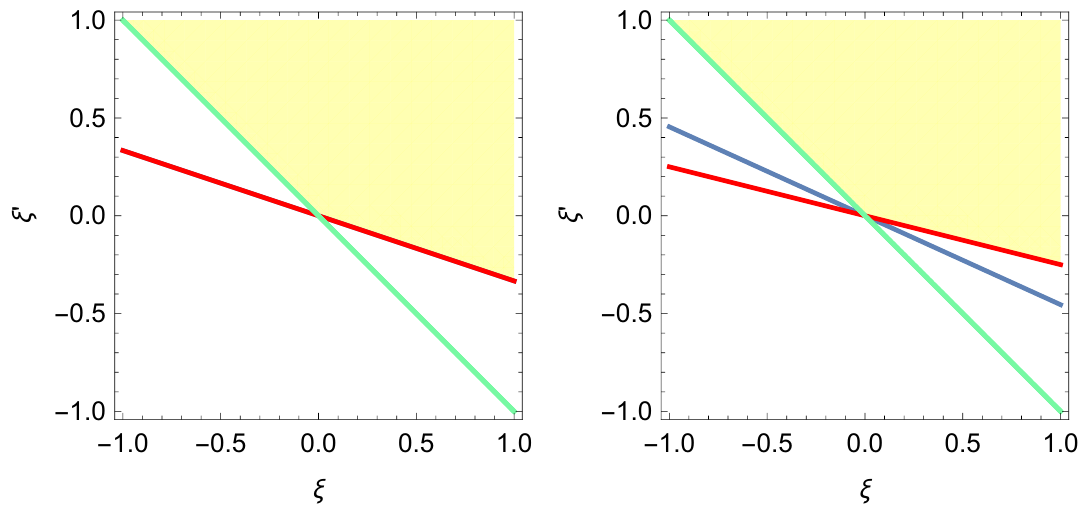
Figure 1 . Allowed regions of the ( ξ, ξ 0 ) plane, The left panel corresponds to the case n = 5 . The right panel is the plot for n = 6 , which illustrates the qualitative behavior for n > 5 . In green, blue and red are the null conditions for eqs. (3.9), (3.10) and (3.11) respectively. Conditions (3.10) and (3.11) are degenerate for n = 5